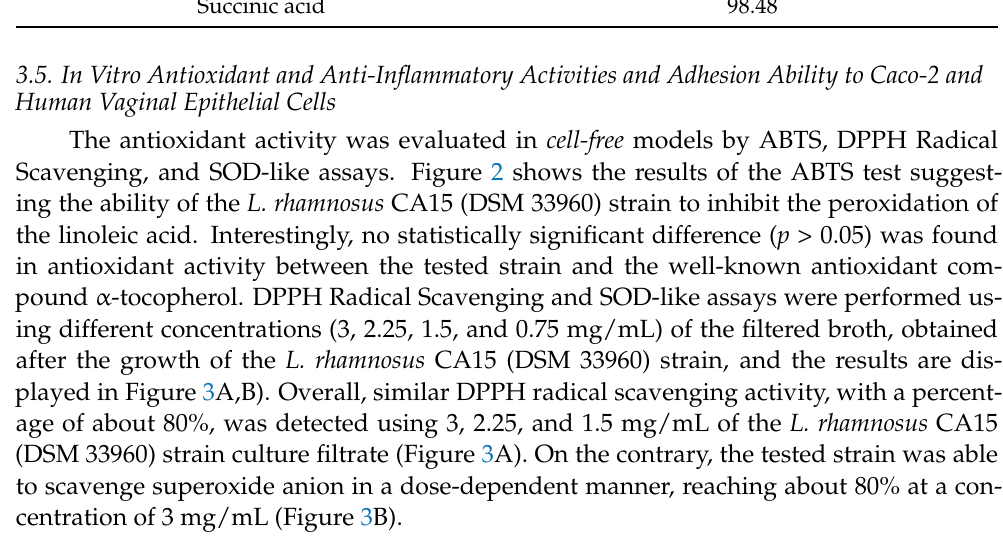
Figure 3. DPPH scavenger and SOD-like activity explicated by the CA15 (DSM 33960) strain tested at different concentrations (3, 2.25, 1.5, and 0.75 mg/mL) (Panels A , B ); LPS treatment (100 µg/mL) effect on mitochondrial membrane potential (Panel C ) (** p < 0.005 vs. CTRL); Assessment of Caco-2 cell viability after treatments (Panel D ); Measurement of IL-6 and IL-2 levels in cell supernatants by ELISA (Panels E , F ) (* p < 0.05, *** p < 0.0005 vs. CTRL; and ### p < 0.0005 vs. LPS). The ability of LPS to induce oxidative stress in the Caco-2 cell line was evaluated by measuring the levels of JC-1, a cationic dye that accumulates in the mitochondria, as dimer JC-1 or monomer JC-1. As shown in Figure 3C, a low signal of JC-1 dimer (red fluorescence) and a high presence of JC-1 monomer (green fluorescence) were detected in LPS-treated Caco-2 cells, indicating the induction of oxidative damage and mitochondrial dysfunction. In addition, as shown in Figure 3D, the LPS treatment was able to induce oxidative stress in the Cac-2 cell line with slight cytotoxicity. No significant differences were observed in the CA15 (DSM 33960) cells treated and in the CA15 (DMS 33960)–LPS- treated cells, compared to the control group. A significant reduction in the IL-6 levels was detected in LPS-treated Caco-2 cell lines after treatment with the L. rhamnosus CA15 (DSM 33960) strain culture filtrate, suggesting